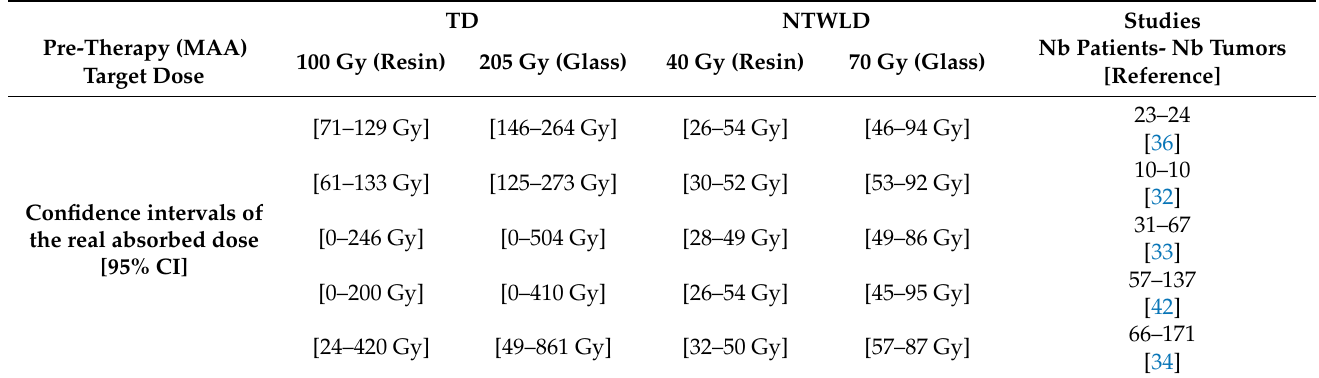
Table 5. Confidence intervals of the real post-therapy absorbed doses after targeting doses on MAA imaging for HCC tumors. 95% confidence intervals are based on the results of previous studies shown in Table 3. TD NTWLD